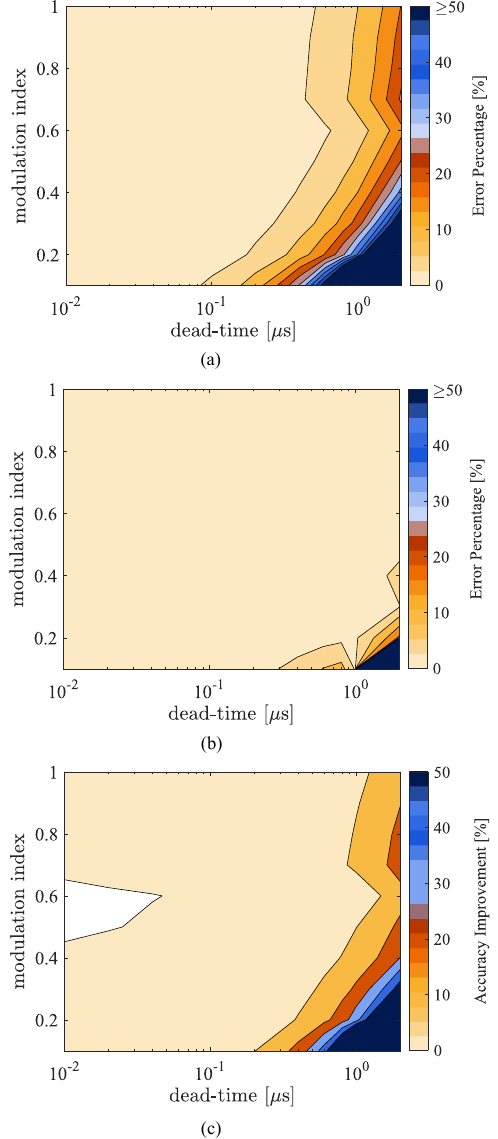
Figure 10. Absolute error percentage of the ( a ) benchmark and ( b ) proposed equations; ( c ) rela- tive improvement of the proposed equations compared to the benchmark equations (case 2 load,